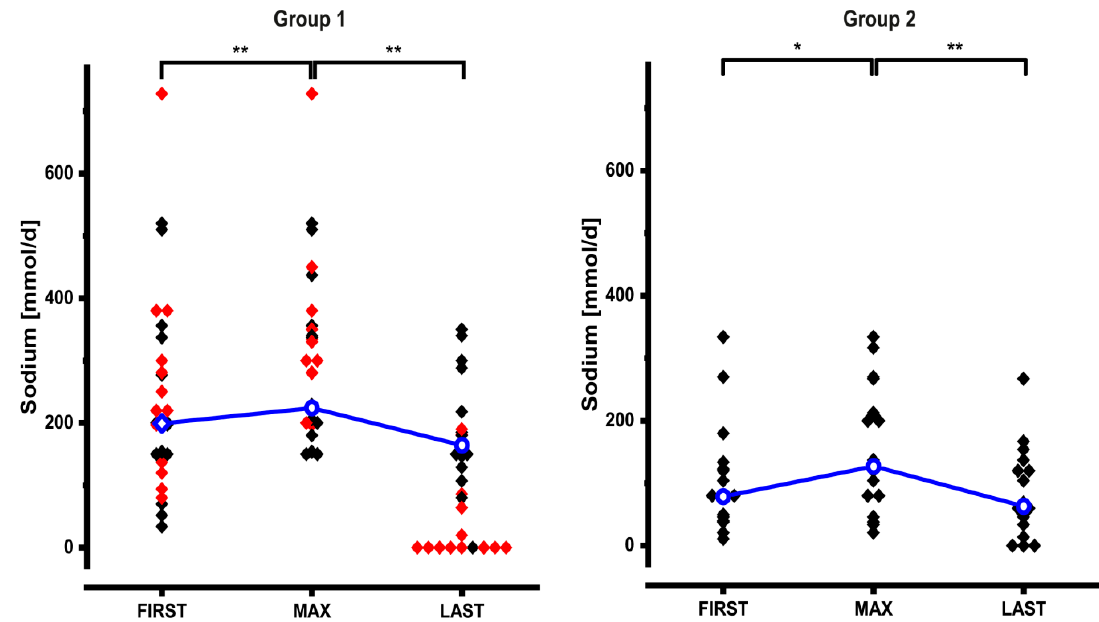
Figure 4. Dynamic changes of sodium support in group 1 and group 2 patients. In group 1, 11 patients had reconstructive surgery and 2 patients received teduglutide between MAX and LAST, they are indicated as red symbols and they are not included in the statistical analysis (median values and significant differences) at time point LAST. Median values are connected by the blue line. See text for details (* p < 0.05; ** p < 0.01).